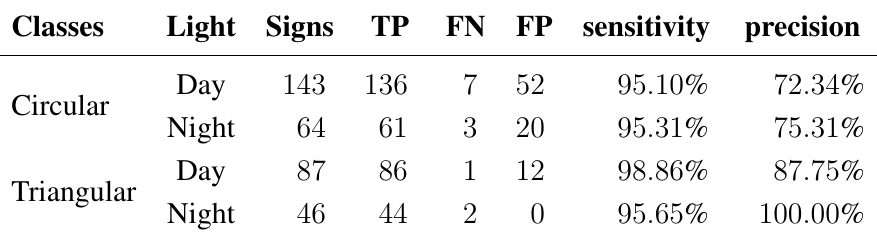
Table 2. Summary of detection results under different lighting conditions.